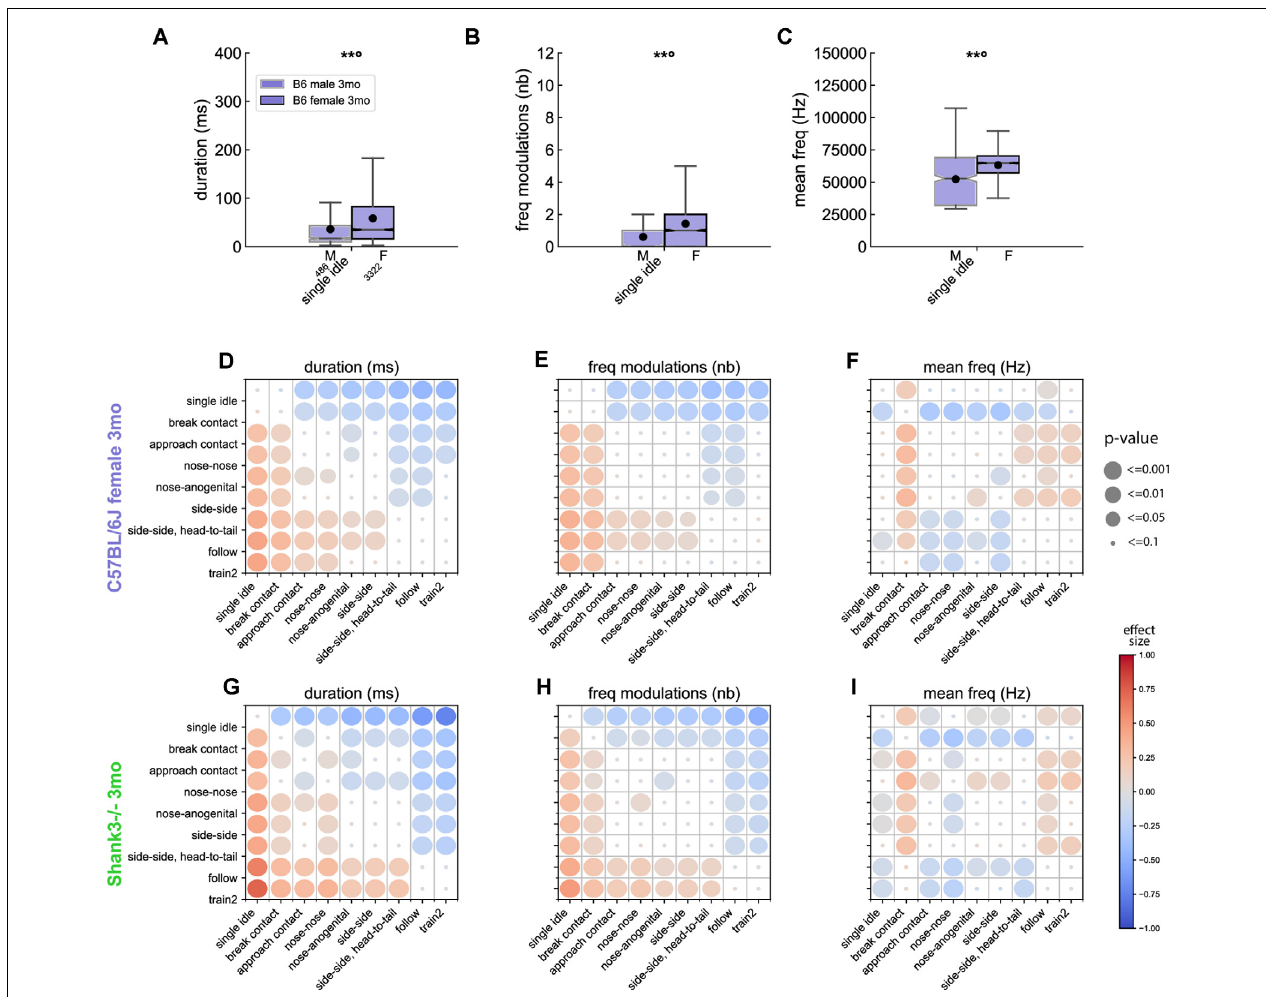
FIGURE 5 | Acoustic variations of USVs between contexts of emission in B6 and Shank3 − / − mice. Sex-related variations in (A) the duration, (B) the number of frequency modulations, and (C) the mean frequency of USVs emitted during single idle by 3 months old male (486 USVs) and female (3,322 USVs) B6 mice (Linear Mixed Model with sex as fixed factor and pair as random factor; ns: not significant, uncorrected p -values: ** p < 0.01: p -values followed by ◦ survived the correction for multiple testing for acoustic variables and events). Comparison of the duration (D) , number of frequency modulations (E) and mean frequency (F) of USVs emitted by 3 months old B6 females between the different contexts of emission (Linear Mixed Models with context as fixed effect and pair as random effect). Blue colors indicate that the acoustic feature of USVs given during y-event is lower than the acoustic feature of USVs given in x-event; red colors indicate that the acoustic feature of USVs given during y-event is higher than the acoustic feature of USVs given in x-event; the effect size is represented by the color scale while the significance levels are represented by the size of the circles. Comparison of the duration (G) , number of frequency modulations (H) and mean frequency (I) of USVs emitted by 3 months old Shank3 − / − females between the different contexts of emission (Linear Mixed Models with context as fixed effect and pair as random effect; the effect size is represented by the color scale while the significance levels corrected for multiple testing across acoustic variables and contexts combinations are represented by the size of the